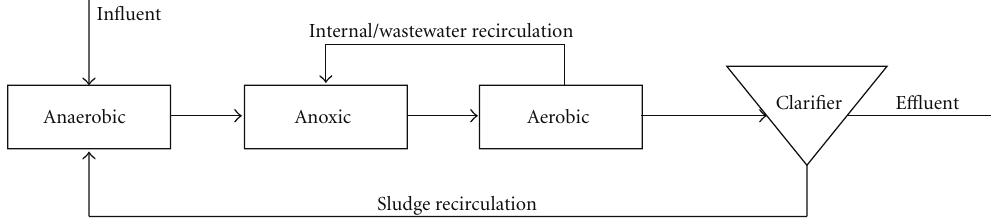
Figure 1: Scheme of A2O-activated sludge system.